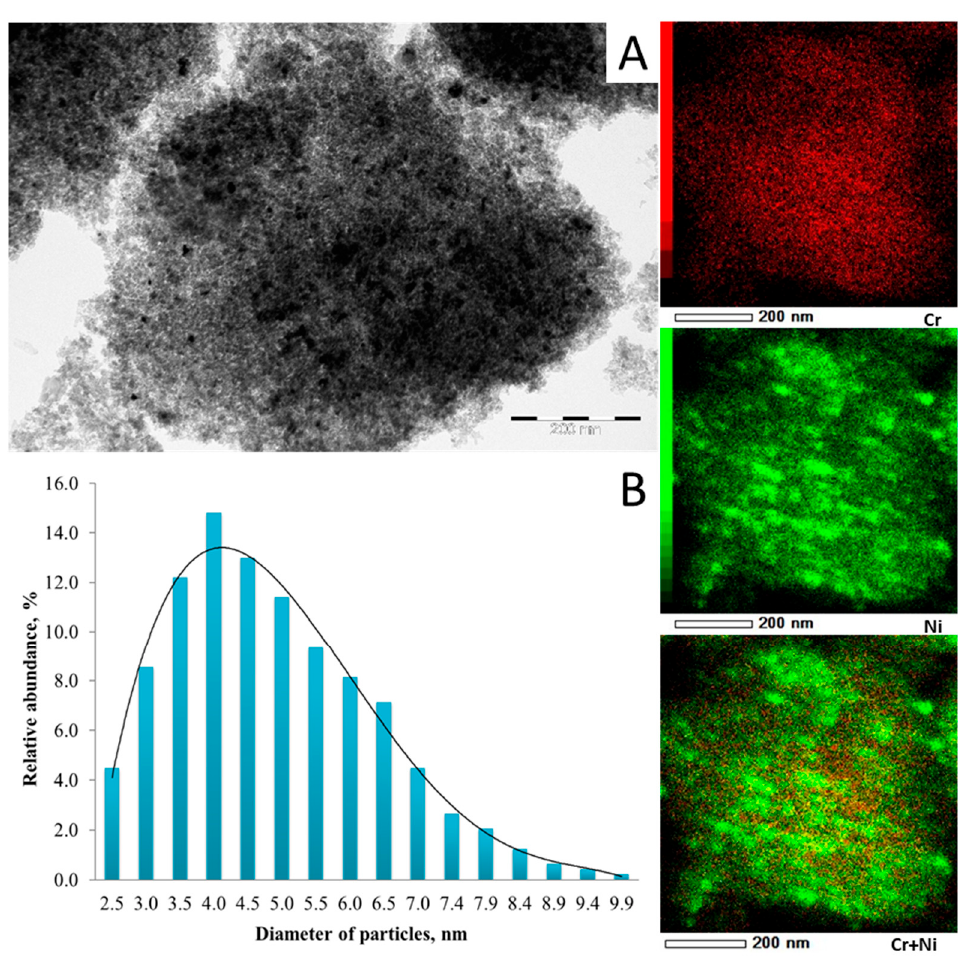
Figure 2. TEM image ( A ) and particles distribution ( B ) in 10%Ni-1.5CrCO / Al 2 O 3 sample.